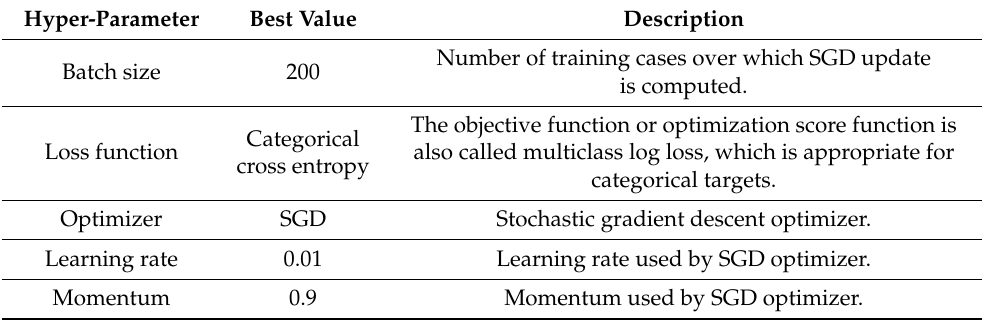
Table 4. Optimized hyperparameters of the proposed CNN model. Hyper-Parameter Best Value Description Number of training cases over which SGD Batch size 200